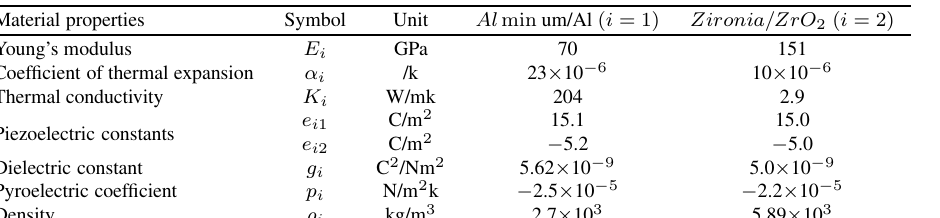
Table 1 Material parameters of FGPM cylindrical shell